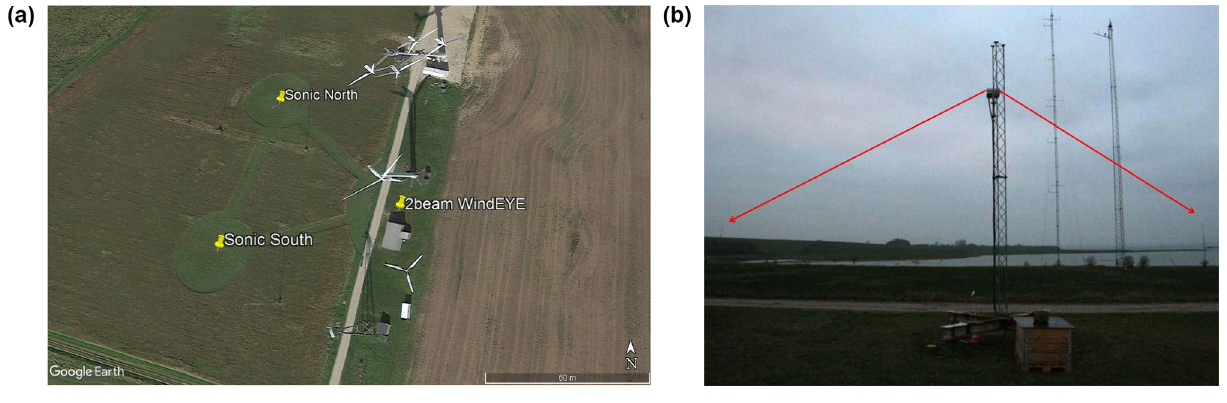
Figure 2. (a) : Google Earth screenshot of the site set-up. (b) Photo depicting the lidar mounted on the mast looking at the two sonic anemometers, from Dellwik et al.